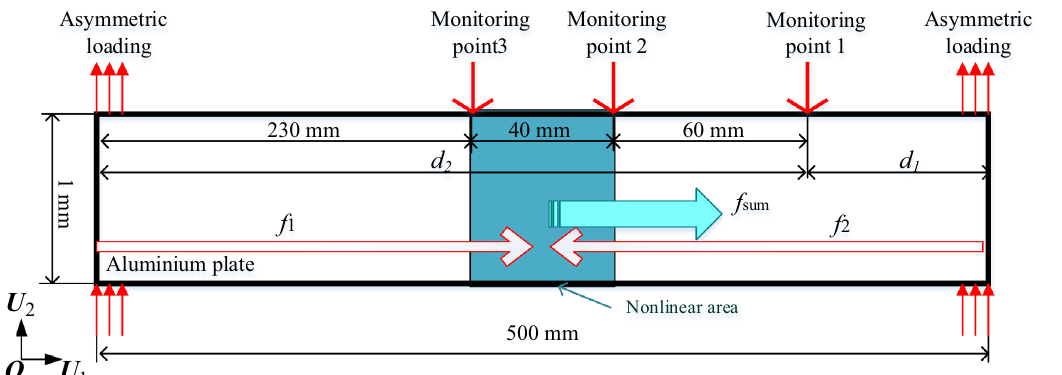
Figure 3 Schematic diagram of finite element model